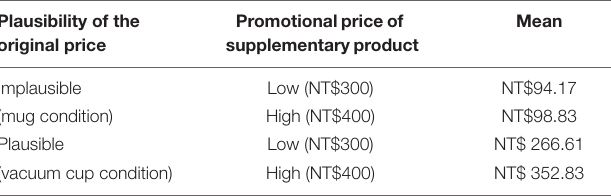
TABLE 2 | Willingness to pay for the mug (or vacuum cup) after the termination of the promotion. Plausibility of the original